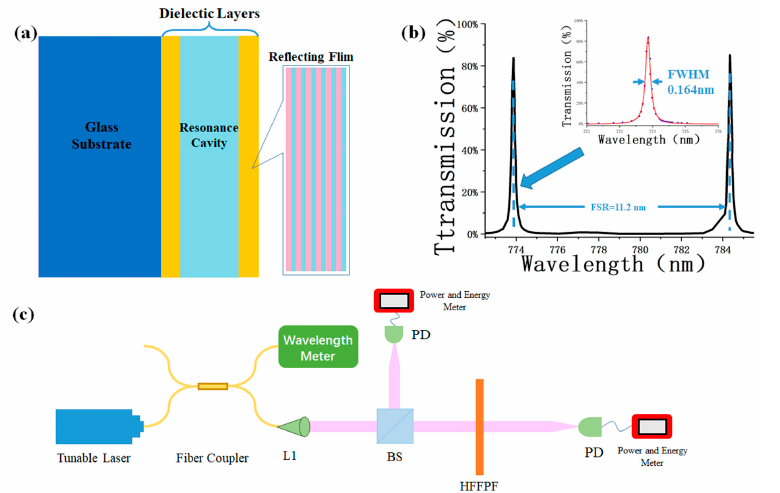
Figure 1. ( a ) Structure of the HFFPF. The dark blue layer is the glass substrate, and the two yellow layers are high-re fl ection fi lms, while the blue layer is the resonance cavity formed by 12-µm Ta 2 O 5 . The inset shows the structure of the high-re fl ection fi lm, which is formed with eight-layer pairs of Ta 2 O 5 and SiO 2 , with a designed re fl ectivity of 97%. The Ta 2 O 5 and the SiO 2 layers are marked in blue and pink, respectively. ( b ) The measured transmission spectrum of HFFPF. ( c ) The setup diagram for the transmission spectrum measurement. L: aspherical lens; BS: beam spli tt er; PD: photodetector. For the laser source in the self-injection, we use a low-cost FP-LD with a TO-can package working at around 785 nm. With a 102.6 mA driven current supplied by a commercial constant-current laser driver module, it has an output power of 49.8 mW. Then we build the self-injection locking setup, as schematically shown in Figure 2. The LD output is fi rst collimated by an aspherical lens, with the beam waist on a 90%- transmissivity partially re fl ecting mirror, which is used to generate feedback for the self- injection locking. The HFFPF is inset between the aspherical lens and the mirror as a narrowband fi lter for the laser feedback. It is tilted slightly to optimize the longitudinal mode matching between the HFFPF and the LD cavity and to avoid unwanted feedback from the direct re fl ection from the HFFPF surface. Another aspherical lens is used to couple laser output into a single-mode fi ber. In this laser, the distance between the LD and the partial-re fl ection mirror is 5 cm; hence, the FSR for this external cavity is ~0.0062 nm. However, due to the low re fl ectivity, the fi nesse F’ of the cavity is only ~1.1. So, the HFFPF is necessary for this cavity for frequency fi ltering to achieve a single-longitude-mode output for the self-injection locking laser.